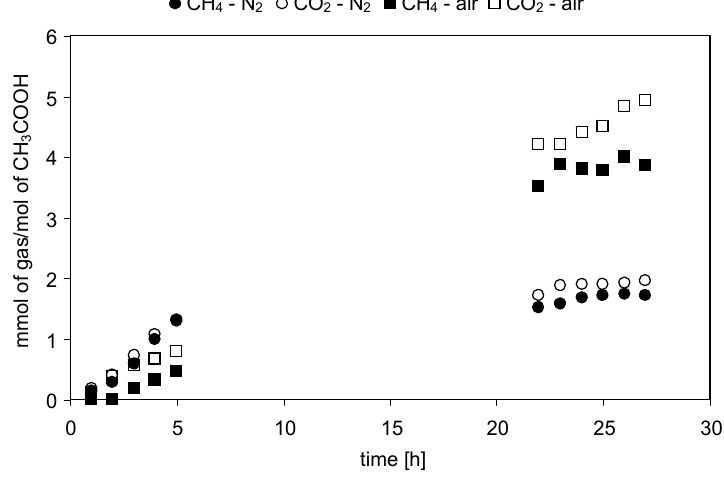
Figure 1. Evolution of CH 4 and CO 2 in time of irradiation during the photocatalytic degradation of CH 3 COOH. Photocatalyst loading: 1g/dm 3 ; CH 3 COOH concentration: 1 mol/dm 3 ; solution pH: 2.6; t = 25 °C.